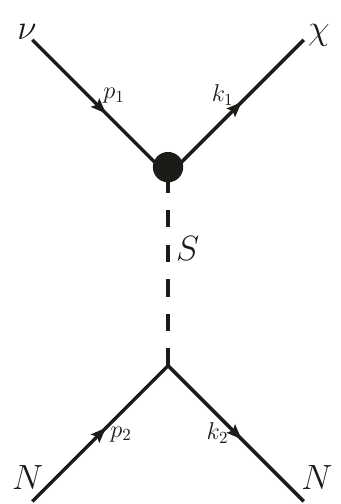
Figure 1 . Feynman diagram for (cid:23)N (cid:31)N coherent scattering mediated by a scalar S . The blob ! represents the (possibly e(cid:11)ective, see section 3.1) (cid:23) - S - (cid:31)